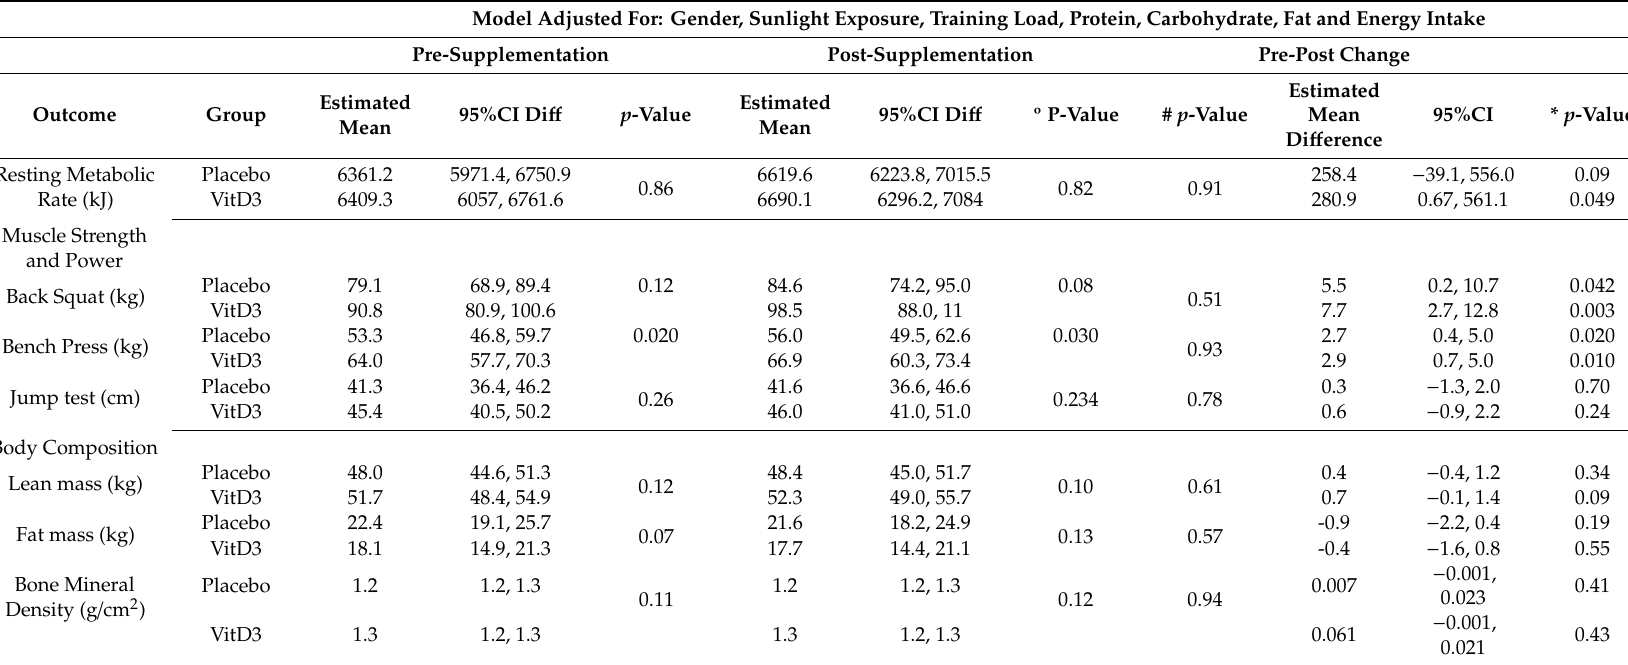
Table 3. Estimated within group means and mean di ff erences of outcomes (pre- and post-supplementation) considering Free total 25(OH)D as the main predictor. Model Adjusted For: Gender, Sunlight Exposure, Training Load, Protein, Carbohydrate, Fat and Energy